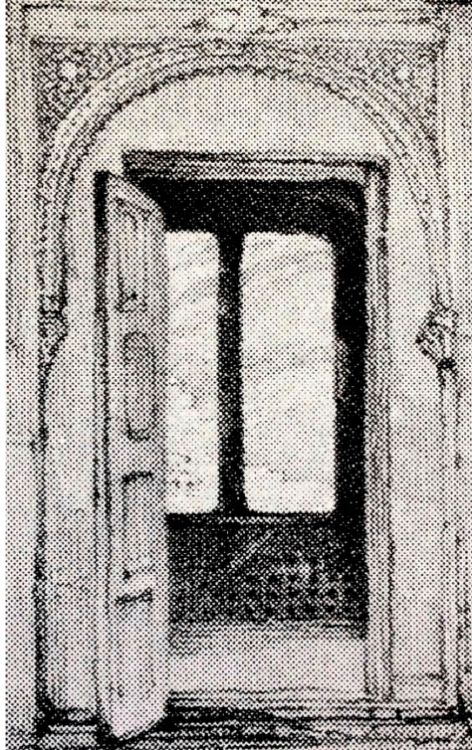
Figure 20. Detail of the alicatado beneath the mullioned window in the Cuarto Dorado. Drawing by John Frederick Lewis (1833–1834). ©Archivo del Patronato de la Alhambra y Generalife, Photograph Collection,